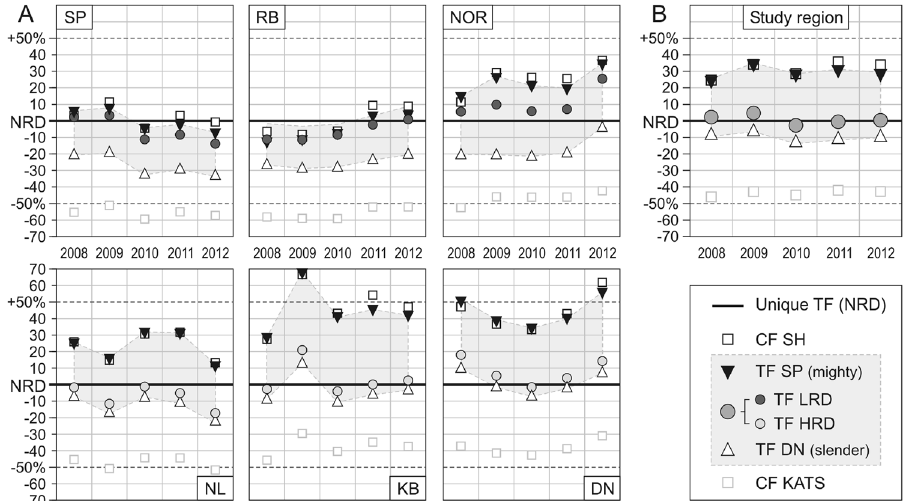
Figure 7. Variability of oyster LWM (kg) RD estimated for the study period 2008-2012. Displayed is the relative deviation (%) from nominal reef density (NRD). NRD was estimated by using unique TF. Devia- tions were estimated by using weighted TF (LRD, HRD), local TF (SP, DN) or CF of two other studies (SH, KATS). A Variability at the study sites. Sites arranged from mighty (SP) to slender (DN) oyster shape, equivalent to increasing reef density at simple (top) and complex reefs (bottom). B Variability in the study region. Range of deviation highlighted for TF of this study (gray